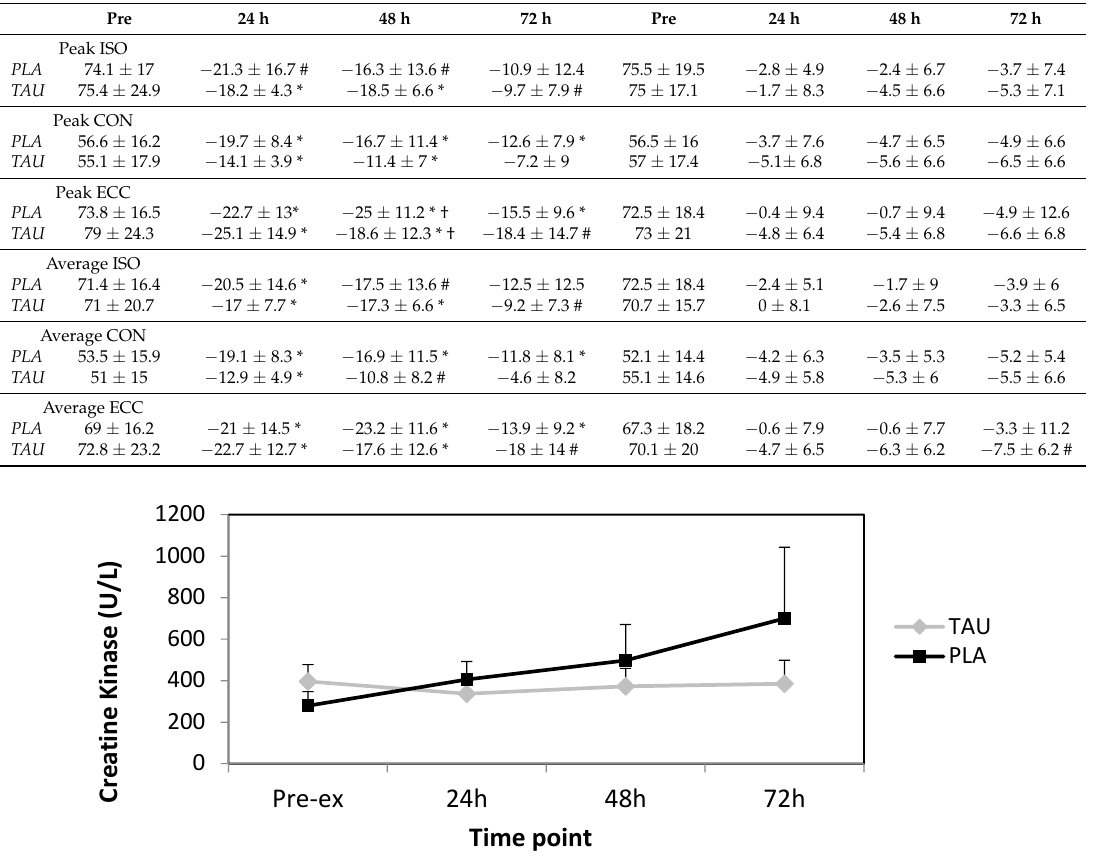
Figure 1. Mean absolute changes in serum creatine kinase (CK) activity following strenuous eccentric exercise with standard error bars. TAU = taurine, PLA = placebo.